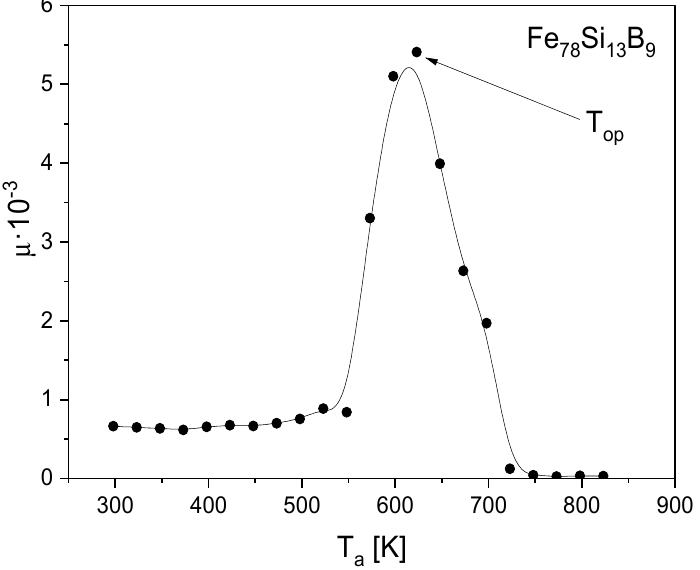
Figure 5. Isochronal magnetic permeability curves versus the 1 h annealing temperature. The magnetic aftereffects curves versus the 1 h annealing temperature are presented in Figure 6. The quantity ∆ µ / µ is proportional to the concentration of relaxators.